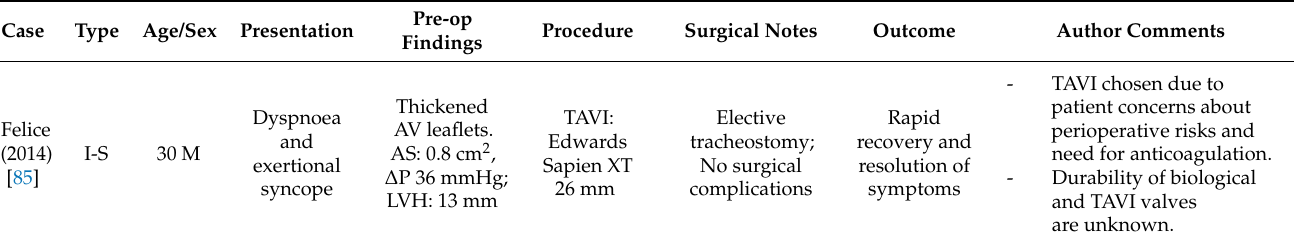
Table 4. Description of the case report of transcatheter aortic valve implantation in a patient with